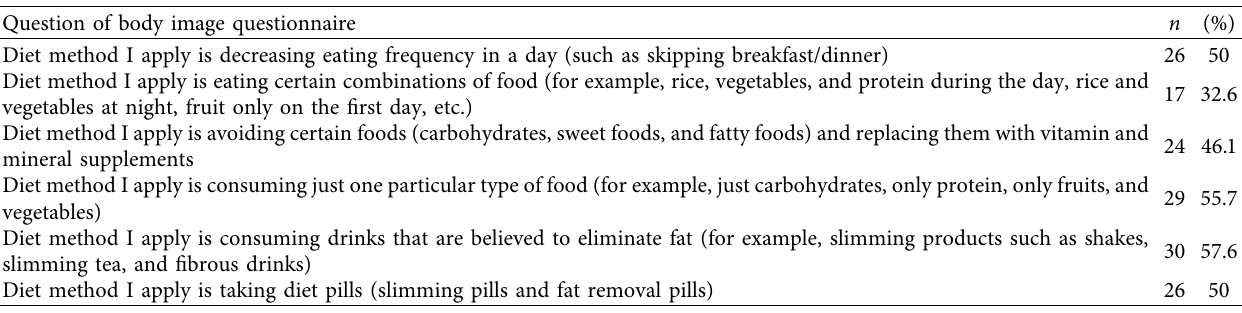
Table 2: The distribution of fad diets based on the questionnaire.